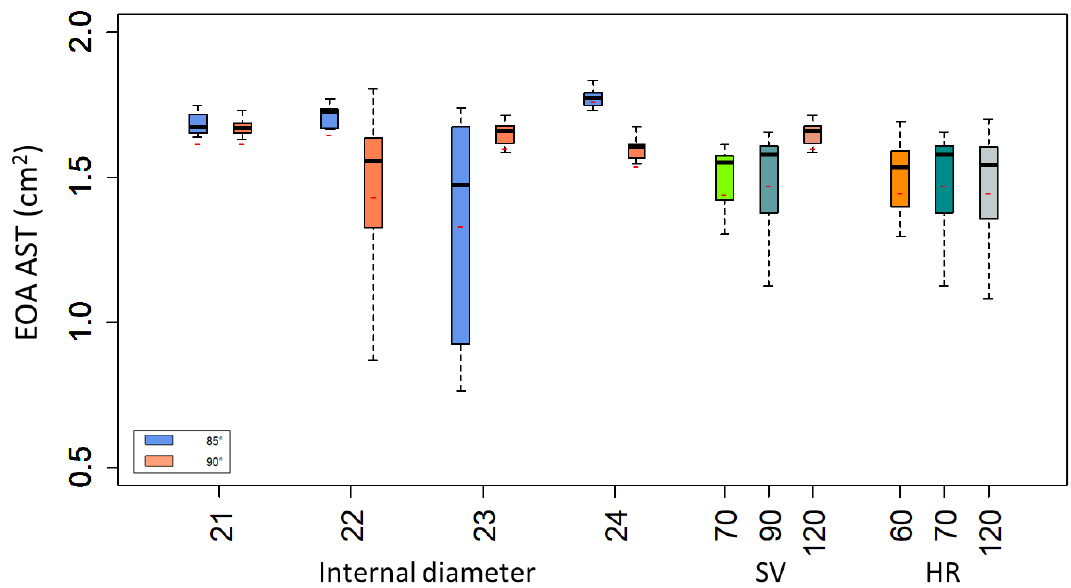
Figure 4. Numerical results—Boxplot representation of the influence of prosthesis design and hemodynamics on the EOA computation. Internal diameter influence 21 to 24 mm, stroke volume: SV of 70, 90, and 120 mL, and HR: Heart Rate: 60 to 120 bpm.